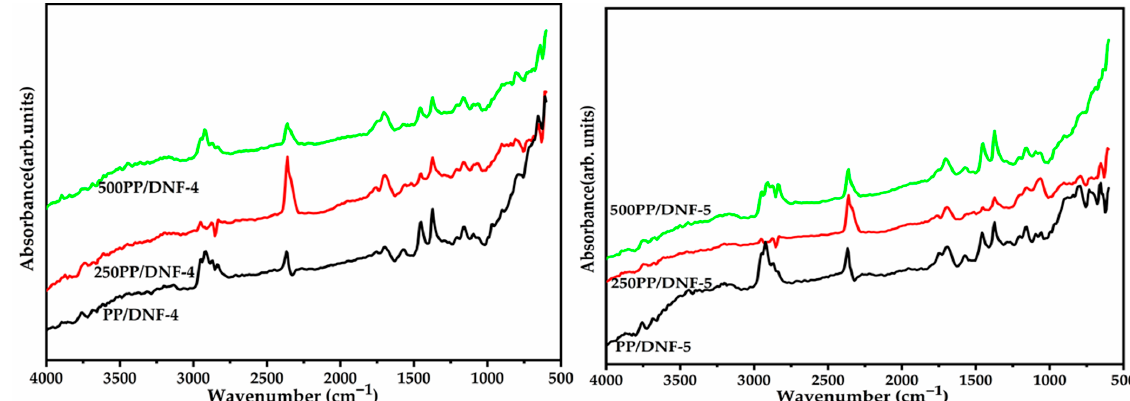
Figure 4. FTIR spectra of PP/DNF composite samples before and after 250 h and 500 h weathering.